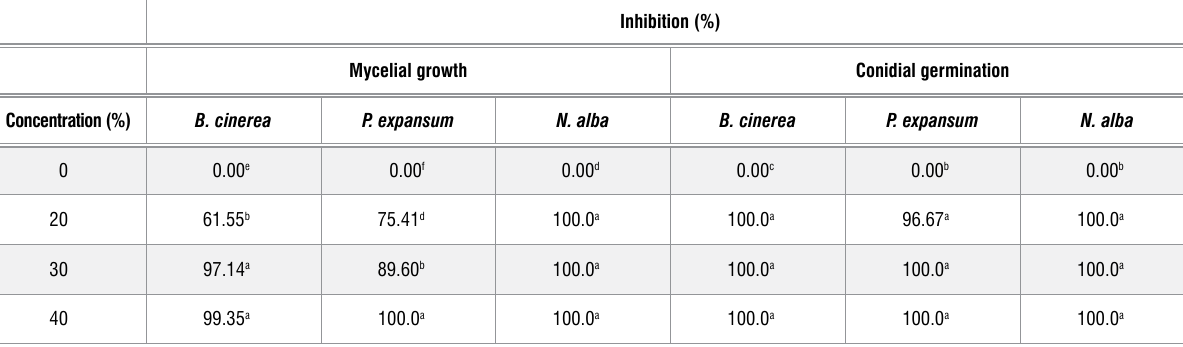
Table 4: Inhibitory volatile action of aqueous extracts against mycelial growth and conidial germination of Botrytis cinerea , Penicillium expansum and Neofabraea alba in phytatrays incubated at 20 °C Inhibition